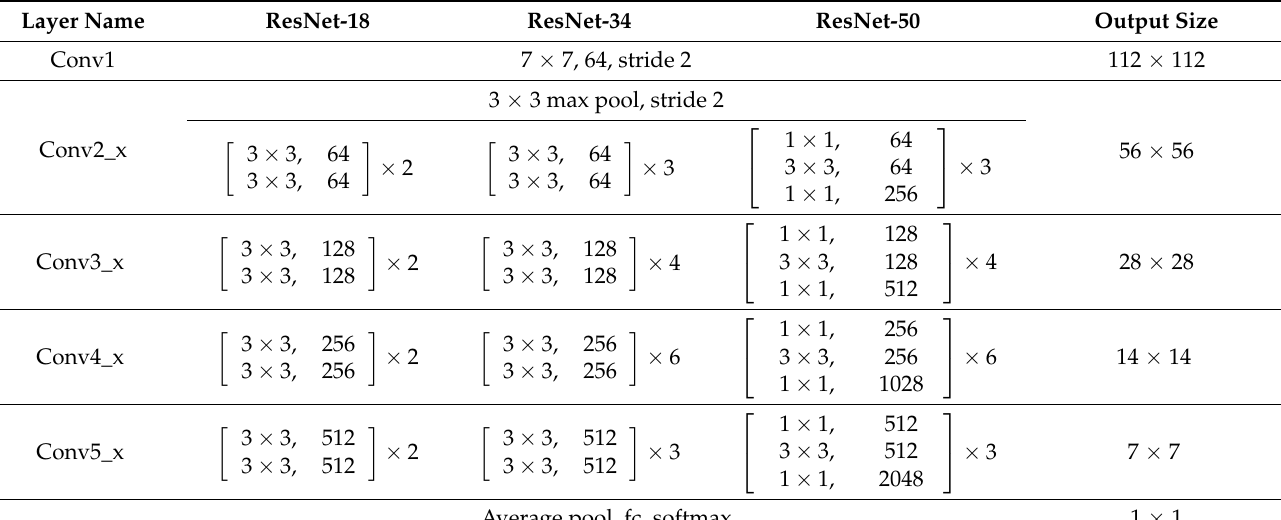
Table 1. Structure of residual networks.